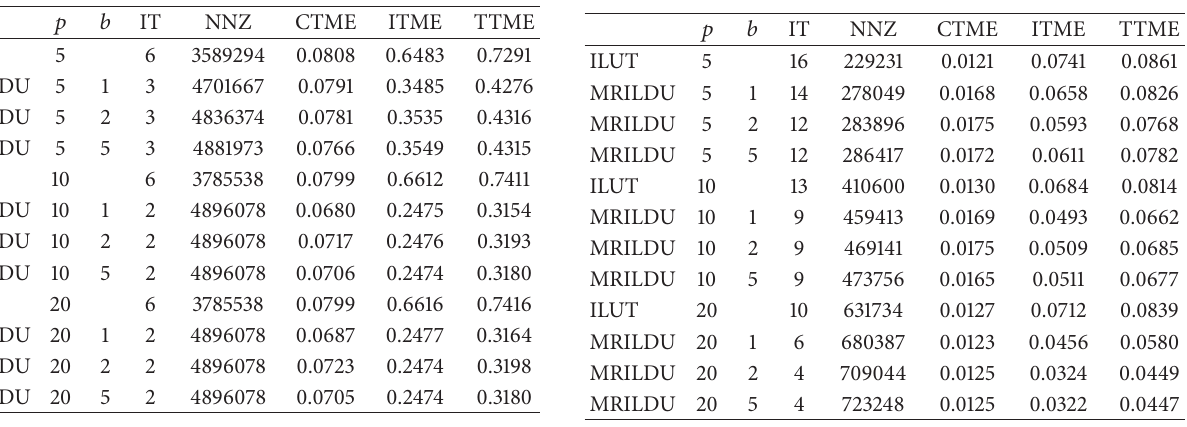
Table 5: Iteration results for matrix thermal2.